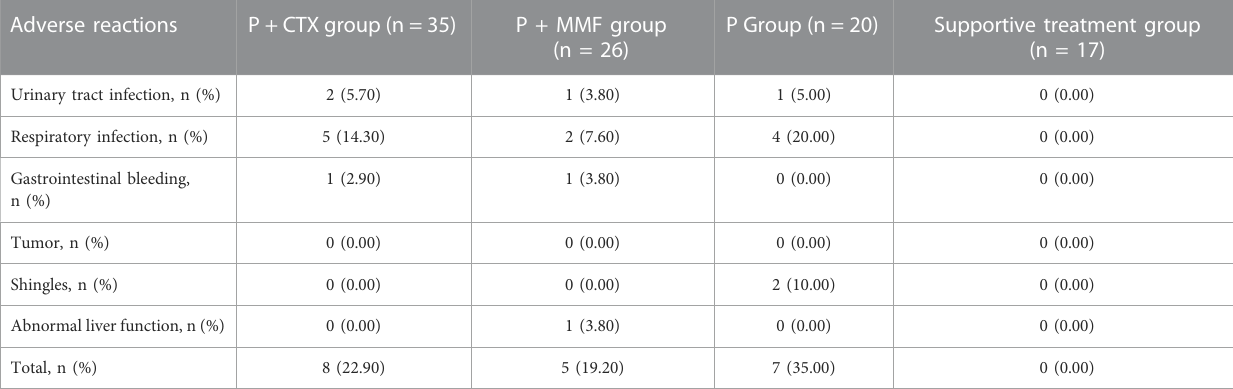
TABLE 8 Comparison of adverse reactions in different treatment groups of severe IgAN. Adverse